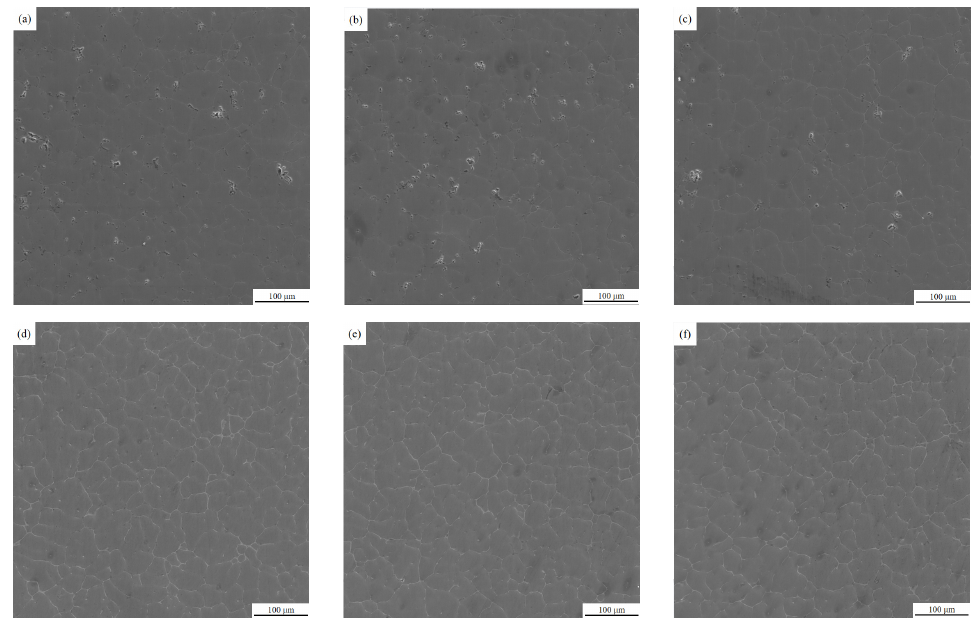
Figure 6. SEM photographs of melt specimens before and after ultrasonic purification treatment: ( a ) Specimen 1 (before treatment) ( b ) Specimen 2 (before treatment) ( c ) Specimen 3 (before treatment) ( d ) Specimen 4 (after treatment) ( e ) Specimen 5 (after treatment) ( f ) Specimen 6 (after